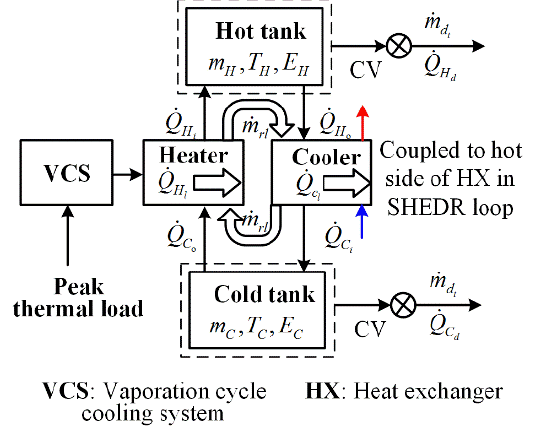
Figure 11. Simplified block diagram laser coolant recirculation loop.